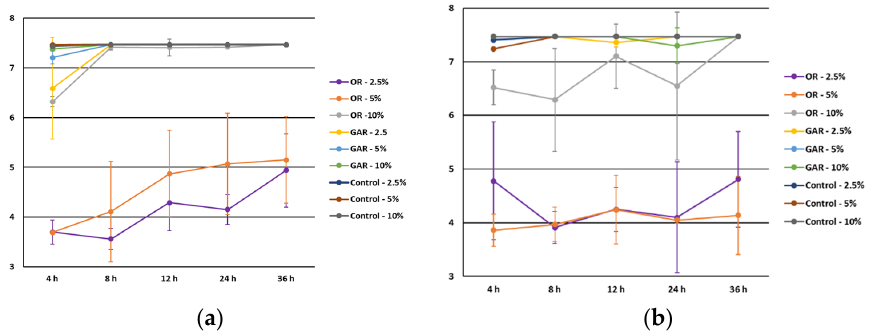
Figure 1. Influence of fat level on the antimicrobial effect of oregano (OR) and garlic (GAR) essential oils against Salmonella spp. ( a ) and Listeria monocytogenes ( b ).